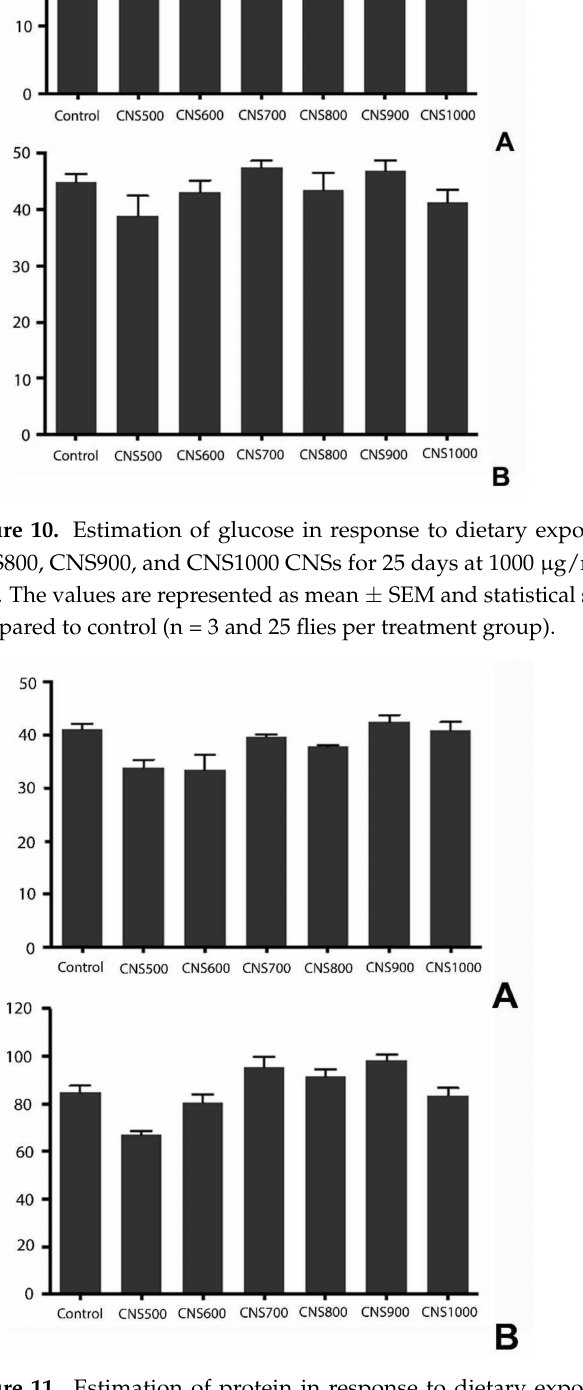
Figure 11. Estimation of protein in response to dietary exposure to CNS500, CNS600, CNS700, CNS800, CNS900, and CNS1000 CNSs for 25 days at 1000 µ g/mL dose in ( A ) male and ( B ) female flies. The values are represented as mean ± SEM and statistical significance was set at p < 0.05 when compared to control (n = 3 and 25 flies per treatment